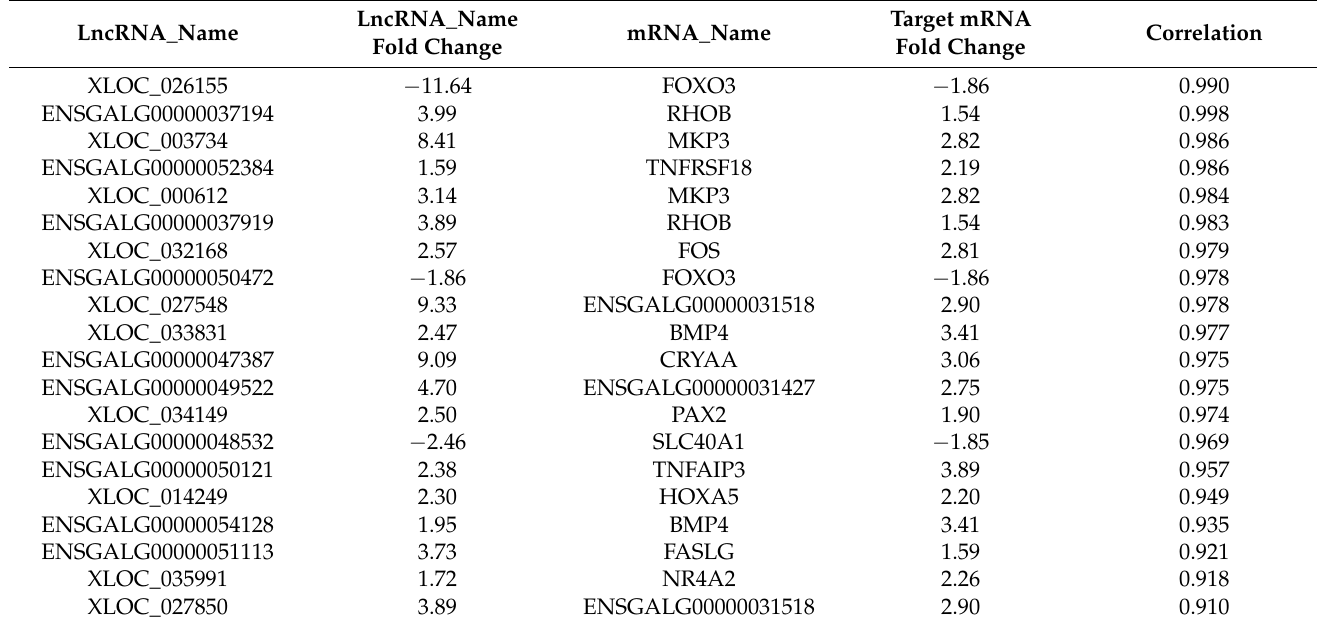
Table 3. The top 20 lncRNA–mRNA pairs related to apoptosis.